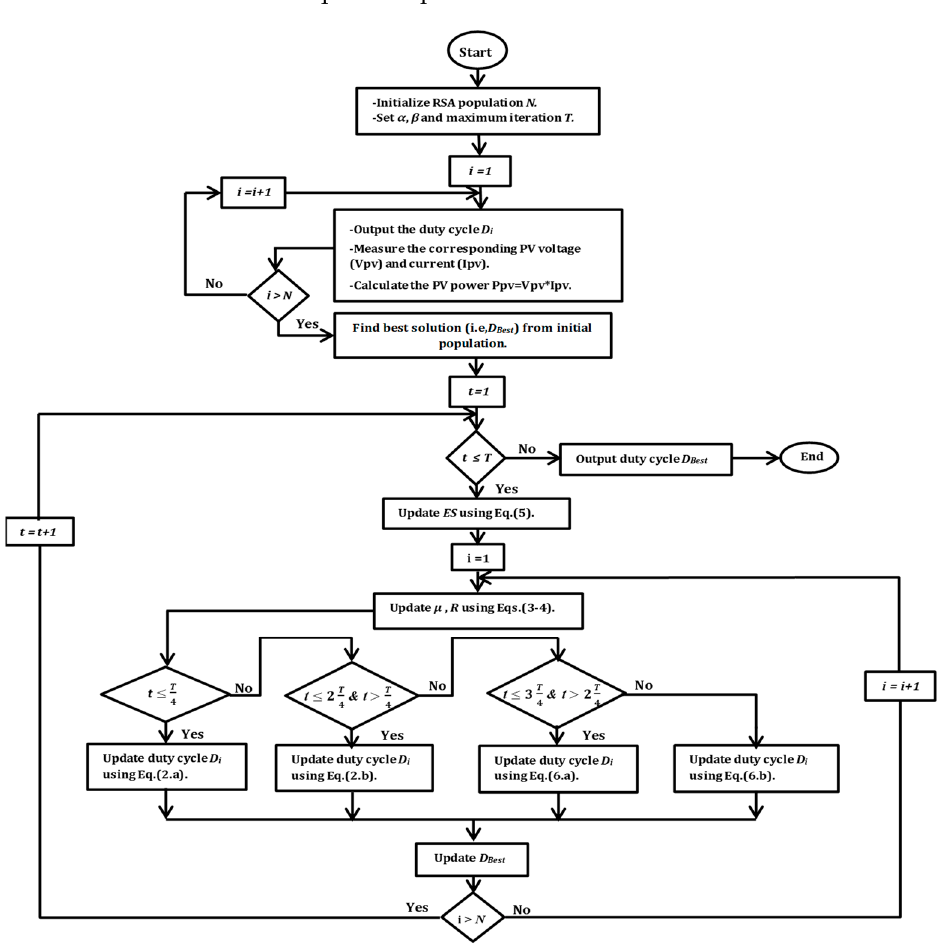
Figure 3. RSA-MPPT based fl owchart.